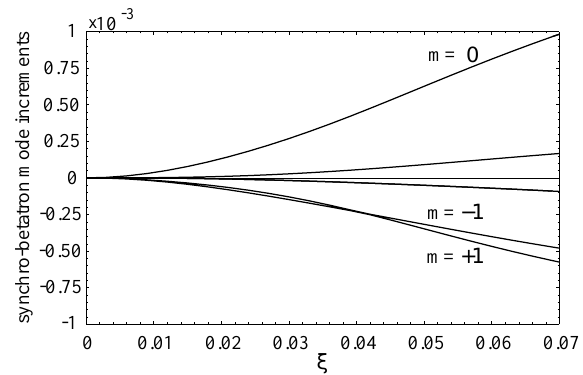
FIG. 8. Synchrobetatron mode increments per turn vs j . The linac-ring scheme, equal beam-beam parameters in both the beams, n b (cid:1) 0.1 , n s (cid:1) 0.002 , and the bunch length is equal to b (cid:1) .